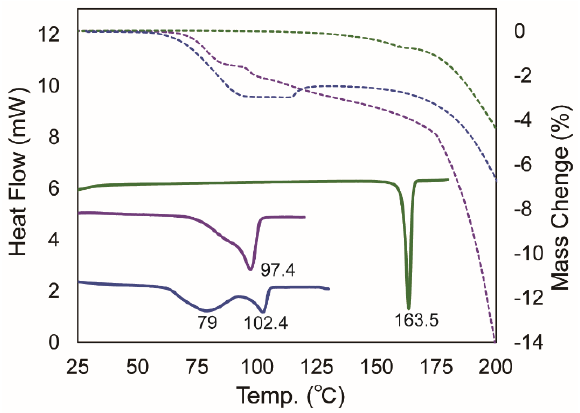
Figure 2. Differential scanning calorimetry (DSC) and thermogravimetry (TG) thermograms of BEX–HCl (blue), BEX–SAC (purple), and BEX–CYM (green). The solid and dashed lines represent DSC and TG thermograms, respectively.